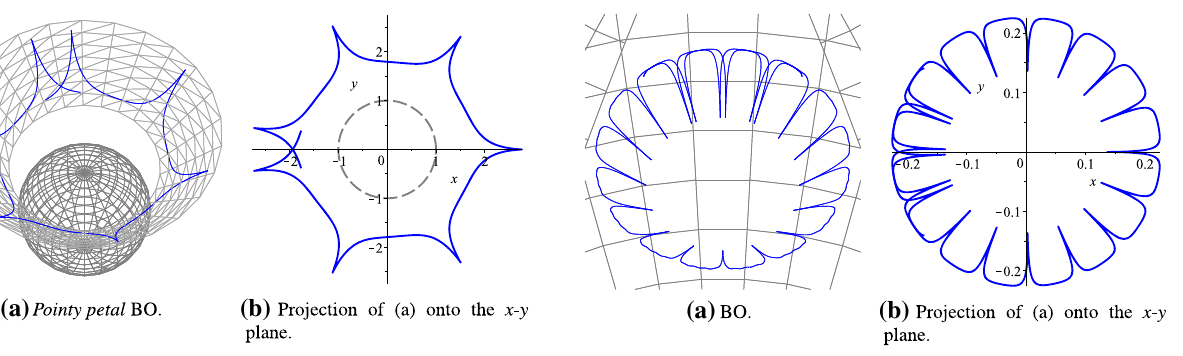
Fig. 12 Pointypetal BOforparameters K = 0 , L = 17 . 1 , δ = 1 , l = 1 , J = 0, and energy E = 0 . 8686915. The trajectory lies on a cone with opening angle θ = π/ 2. The sphere and dashed circle show the horizon at R = 1. The corresponding effective potential and turnaround energy of the r and φ motion, respectively, can be found in Fig. 5c. The particle periodically stops at the outer turning points